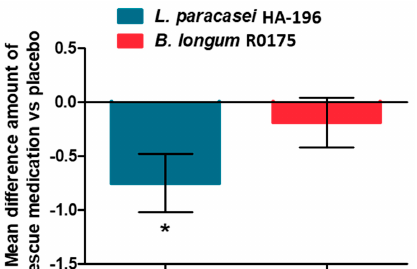
Figure 4. Effect of Lactobacillus paracasei HA-196 and Bifidobacterium longum R0175 on the use of rescue medication (bisacodyl 5 mg tablets) in participants with IBS compared to placebo. L. paracasei group n = 84, B. longum group n = 86, placebo group n = 81; data represented as mean ± SD; * p < 0.05. L. paracasei, Lactobacillus paracasei HA-196; B. longum , Bifidobacterium longum R0175. In participants with IBS-C, there were no significant between-group differences in SBM, CSBM, and stool consistency among the three groups (Table 3). However, L. paracasei and B. longum consumption led to increased number of within-group SBM and CSBM. At week 4, participants with IBS-C reported significant 33% and 24% improvements for the number of weekly SBM from baseline when consuming either L. paracasei or placebo, respectively (both p = 0.007). Although, participants receiving B. longum reported a 19% increase in SBM, it was not statistically significant until week 8, when a 44% improvement was reported ( p = 0.03). At week 8, participants with IBS-C consuming L. paracasei continued to report a significant 33% improvement in the number of weekly SBM from baseline ( p = 0.03). Conversely, a non-significant 11% decrease in the number of weekly SBM from baseline was reported by the placebo group (Figure 5A,B).